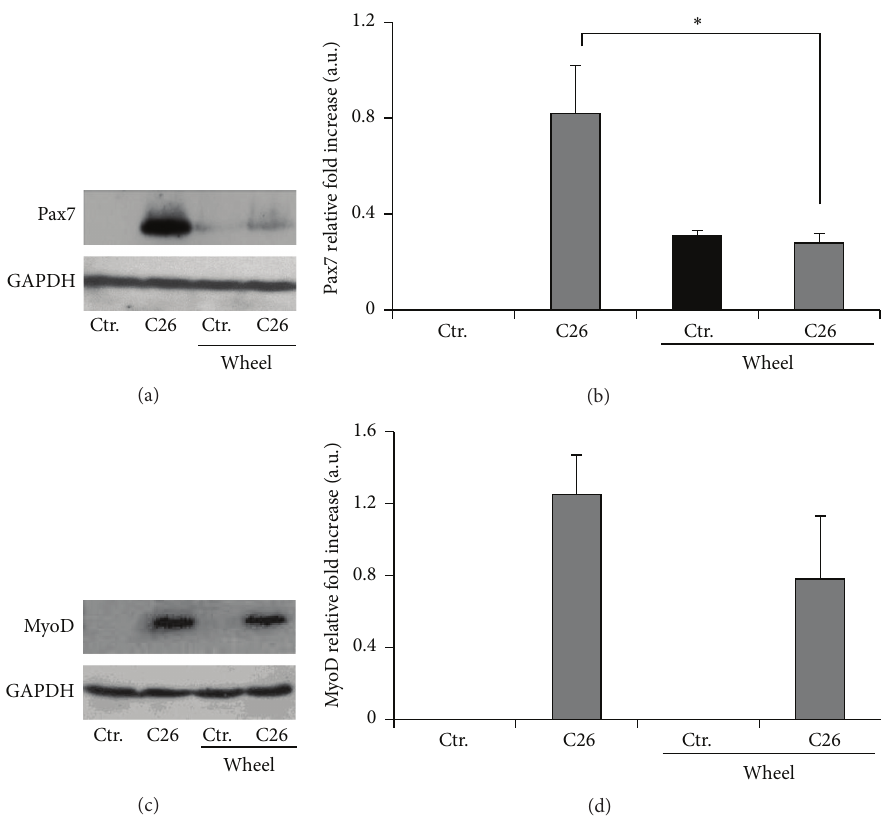
Figure 4: Exercise effects on myogenic markers. (a) Representative WB of Pax7 expression of muscle extracts from mice treated as indicated. (b) Densitometric analysis of Pax7 quantification. GAPDH was used as loading control. (c) Representative WB of MyoD expression of muscular extract from mice treated as indicated. (d) Densitometric analysis of MyoD quantification. Error bars are shown as means ± SEM of five independent experiments; ∗ 𝑝 < 0.005 by one way ANOVA.